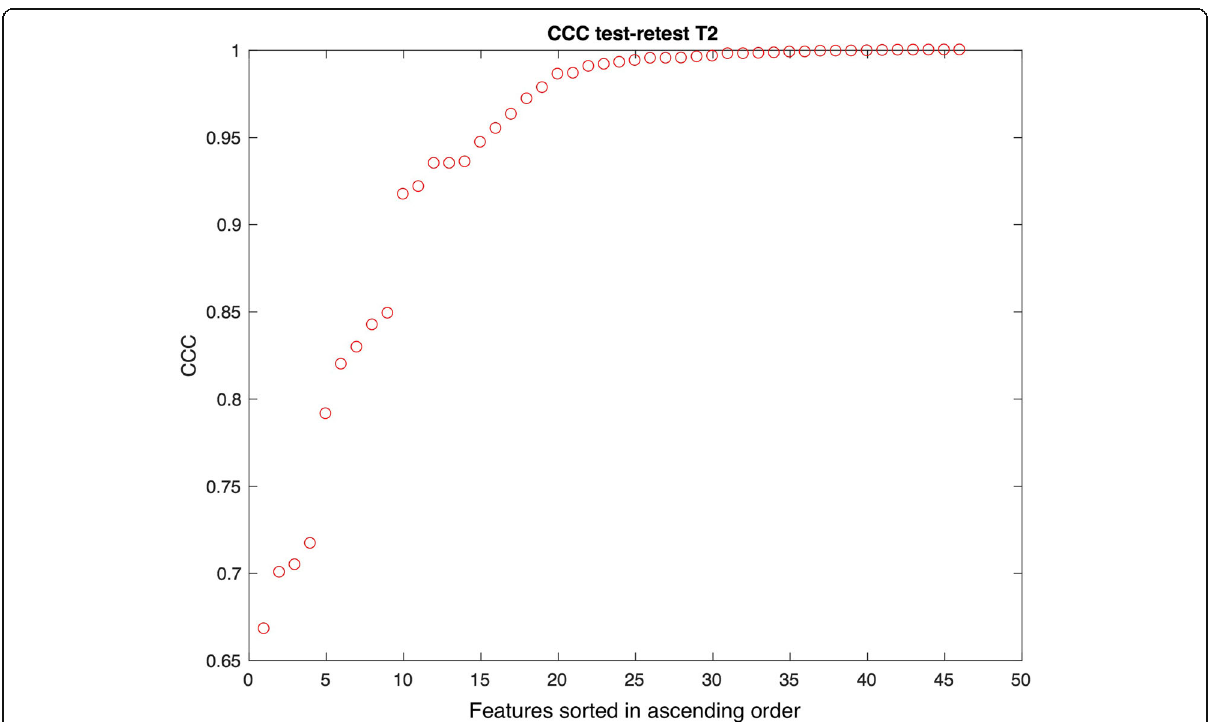
Fig. 5 T2-weighted imaging. Concordance correlation coefficient (CCC) for 46 features (14 statistics and 32 texture features) in the test-retest experiment, sorted in ascending